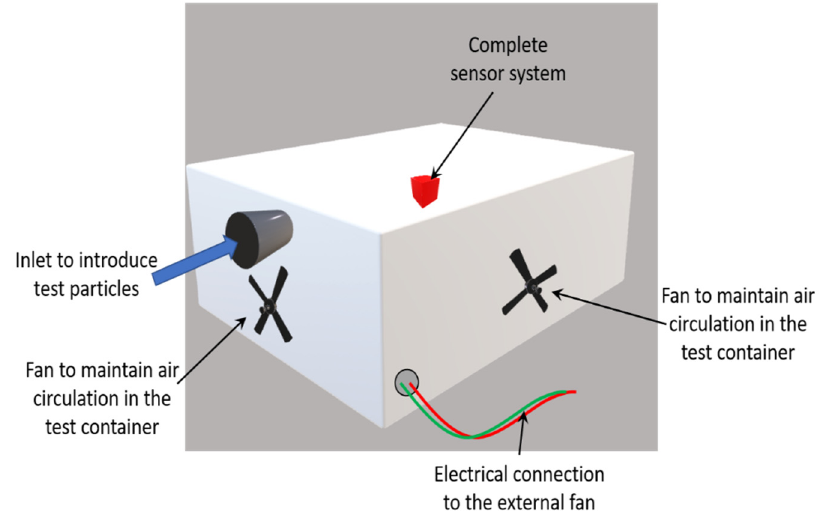
Figure 9. Diagram depicting the test setup with an inlet to introduce the test particles (chalk powder and fluorescent particles). The fans on the inside walls help maintain the circulation of the air inside the container. The complete sensor system is placed inside the container, with a hole that facilitates the electrical connections for the fan of the sensor.